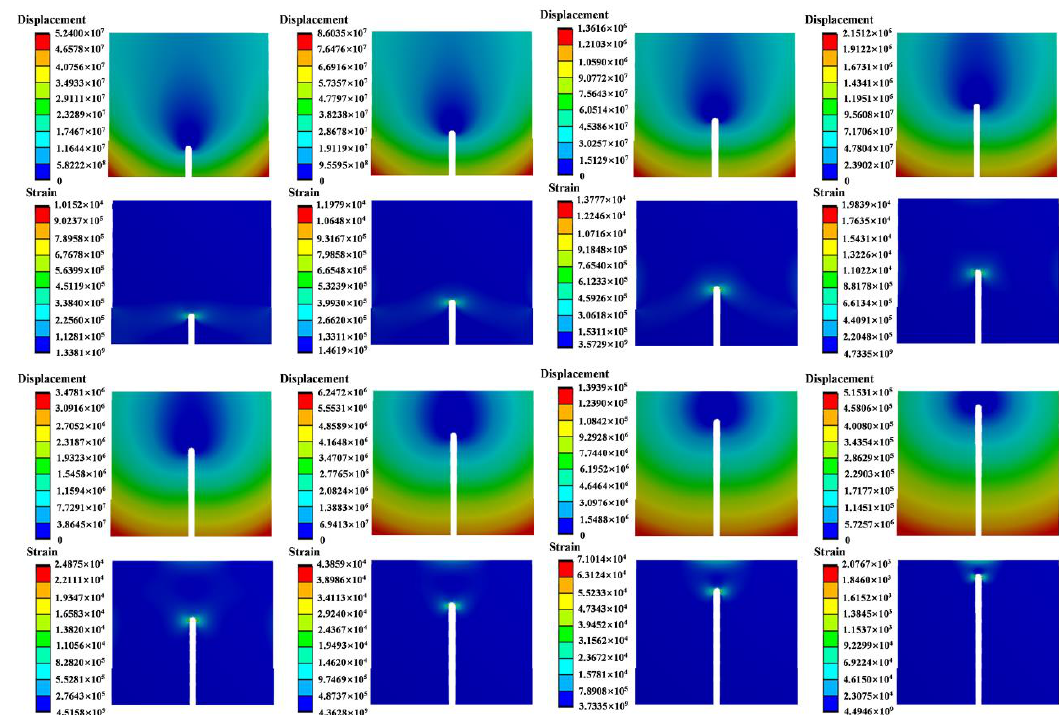
Figure 6. Finite-element-simulation analysis of the influence of slit length on the slit-wake defor- mation as well as the stress concentration on the slit tip.